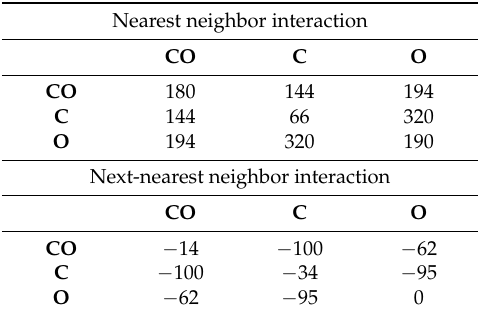
Table 4. Interaction energy, ε i-j (meV) for nearest and next-nearest neighbor interactions. Nearest neighbor